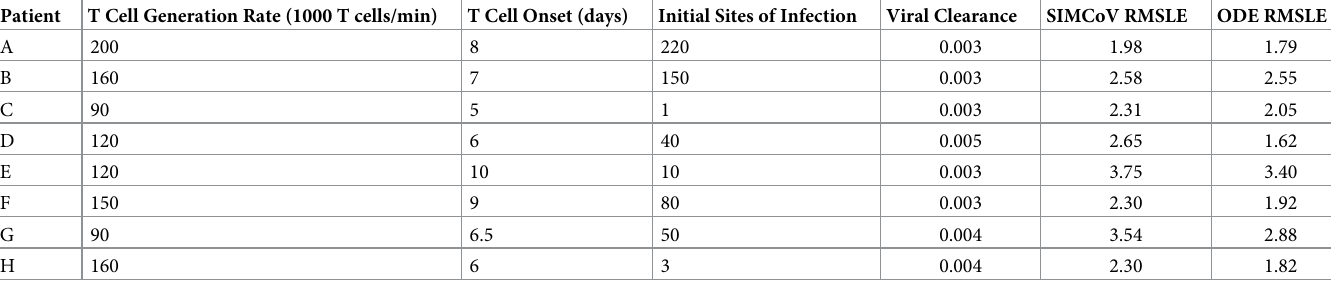
Table 1. SIMCoV parameter settings used for each patient; RMSLE for the simulation averaged over 10 runs and RMSLE for the ODE. Patient T Cell Generation Rate (1000 T cells/min)